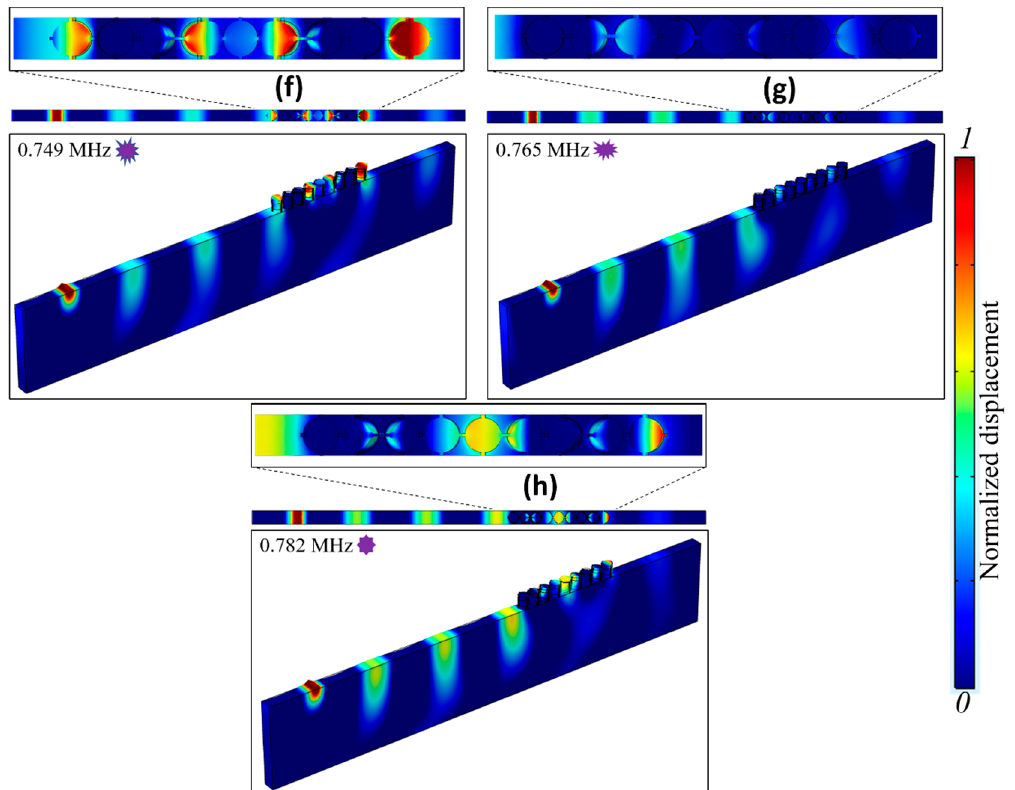
Figure 7. SAW defect analysis for h 2 d = 0.8 a ; ( a ) the schematic diagram in which defect location is highlighted, and the transmission curve is plotted. At defect position ( b , h ) SAW trapping ( c – e , f , g ) vibration isolation where partial SAW propagation in neighboring parent cells occur can be seen.